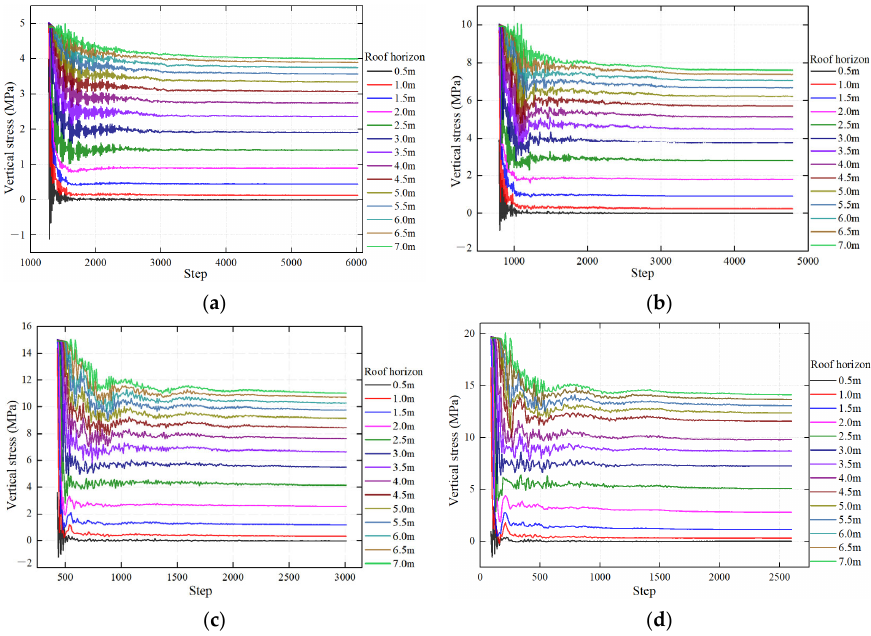
Figure 5. Stress evolution of rock masses at different horizons of the roadway roof: ( a ) roadway at the buried depth of 200 m; ( b ) roadway at the buried depth of 400 m; ( c ) roadway at the buried depth of 600 m; ( d ) roadway at the buried depth of 800 m.